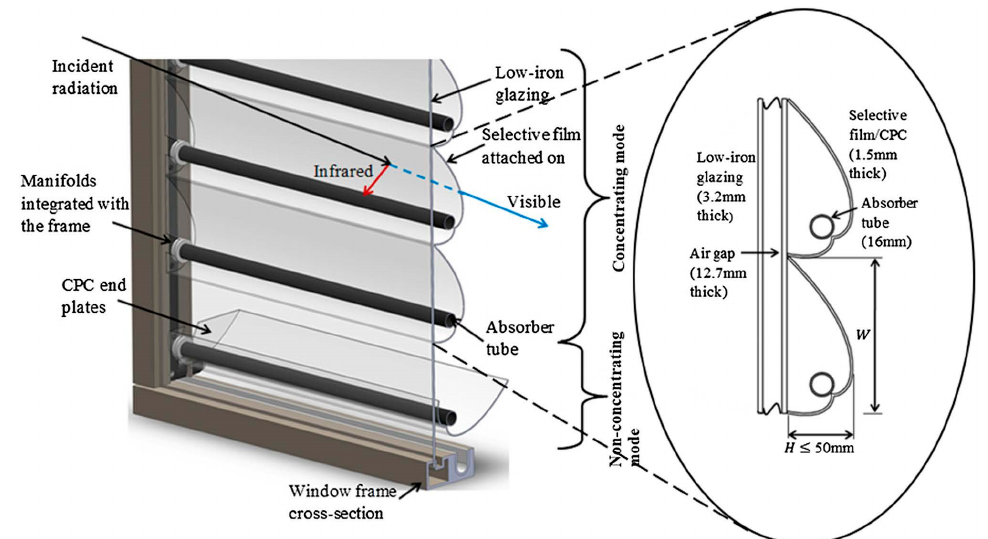
Figure 34. Schematic diagram of hybrid solar window [68].